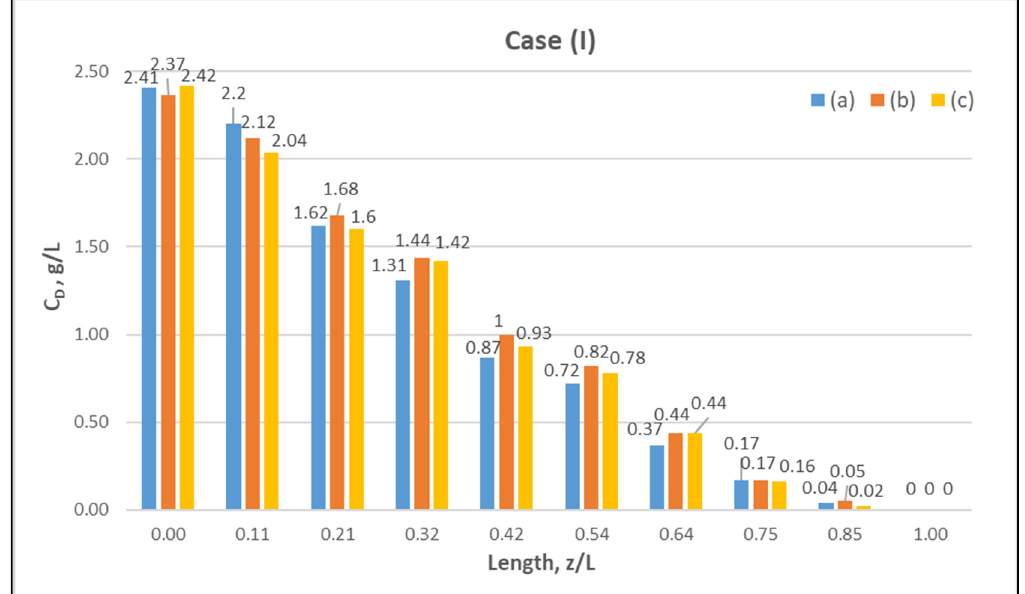
Figure 6. Measured (in triplicate—tests a, b, c) local urea concentration C D on the shell side of the module. Case (I): flow rates Q Blood = 200 mL/min, Q Dialysate = 300 mL/min.